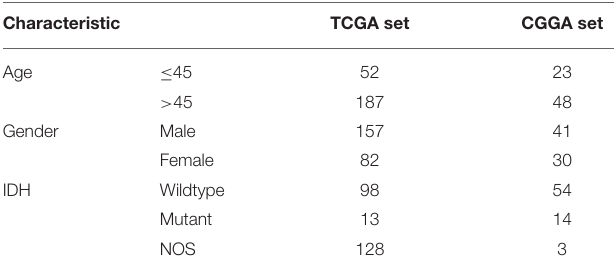
TABLE 1 | Summary of patient’s clinical